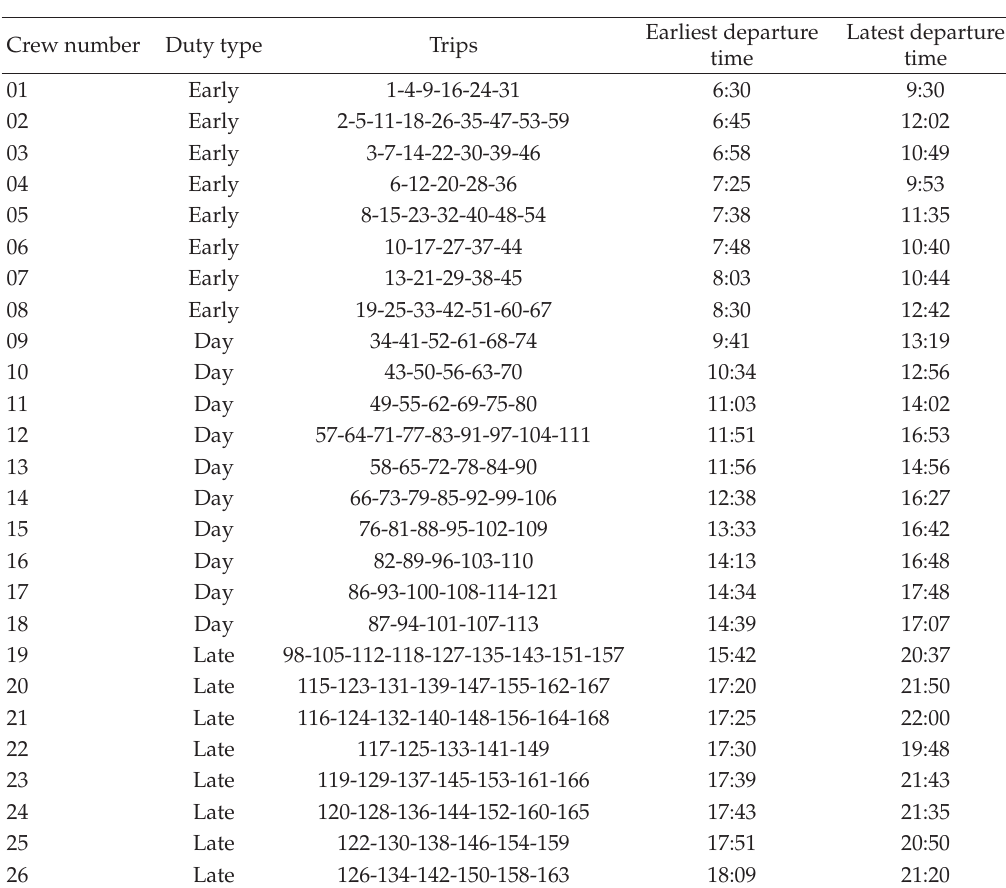
Table 3: The optimal results of crew